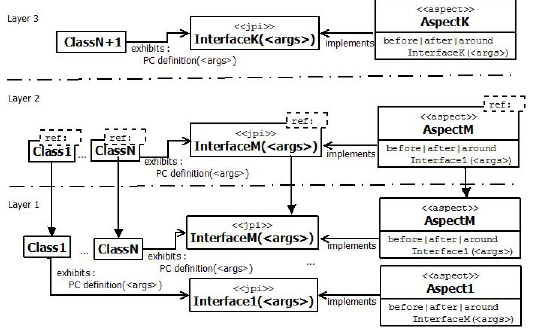
Figure 8: General application of JPI-FM